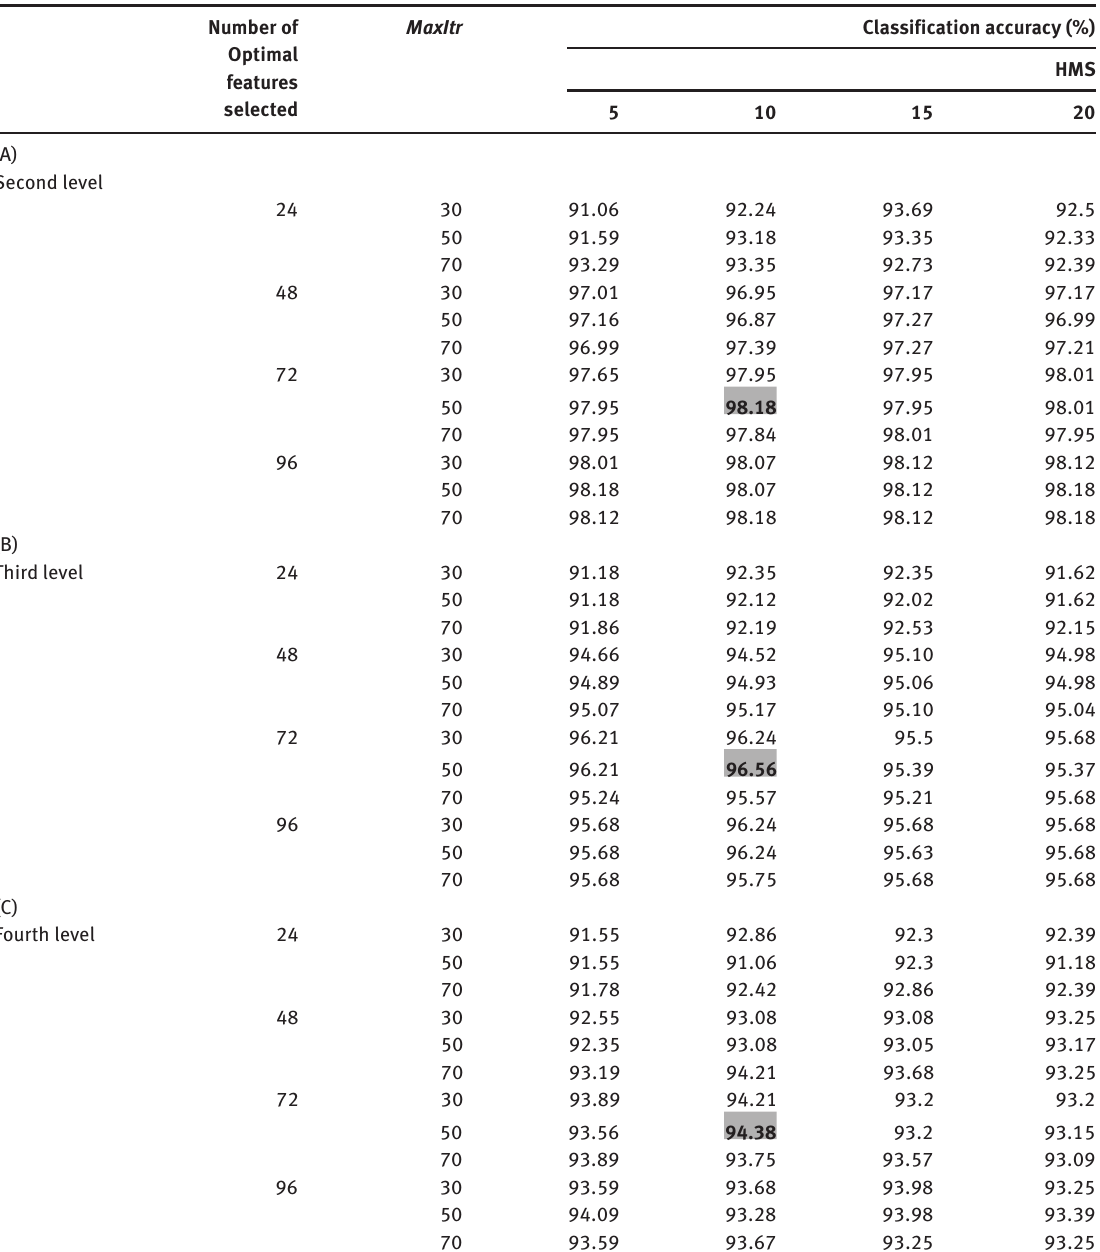
Table 1: Recognition Accuracies of the Present HSA for Different Parameter Values of HMS at (A) Second Level, (B) Third Level, and (C) Fourth Level (Best Case Is Shaded in Gray and Styled in